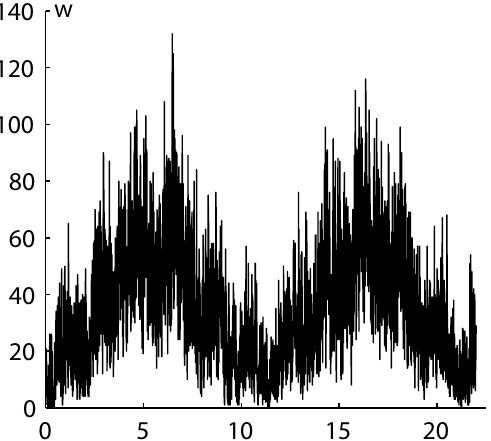
Figure 4. A realization of the AR(1) process introduced in Sect. 3.1, shown prior to smoothing by N days and over the 4-year interval over which it will next be averaged (see text). Model parameters: